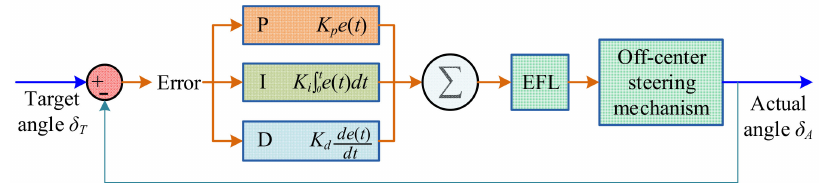
Figure 13. Schematic diagram of the PID control method for the robot steering system.